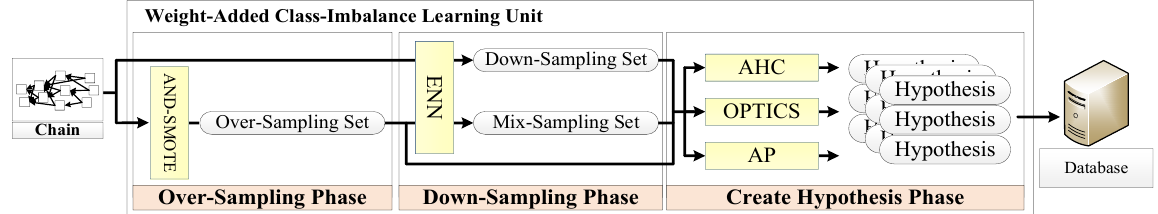
Figure 8. The working flowchart of the weight-added class-imbalance learning unit.